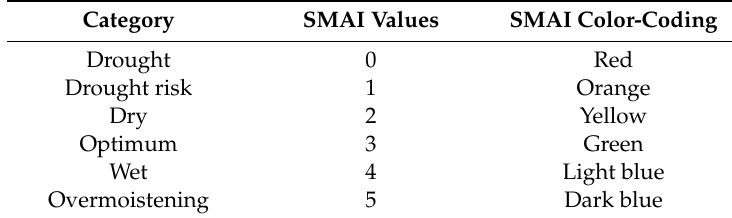
Table 1. Categories of dry / wet classes by the soil moisture availability index (SMAI) following